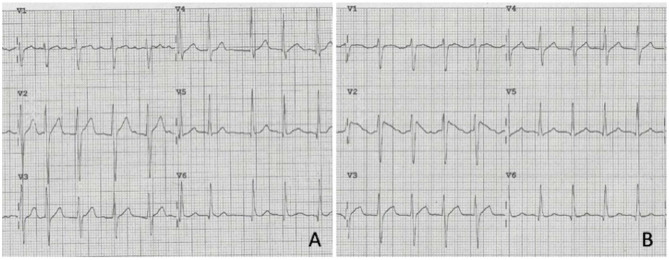
Precordial leads of the ECG of patient No. 13 showing atrial fibrillation with no suspicion for Brugada pattern. (A) At sinus rhythm restoration by IV Flecanide, type 1 Brugada ECG pattern emerged in V1–V2 (B).